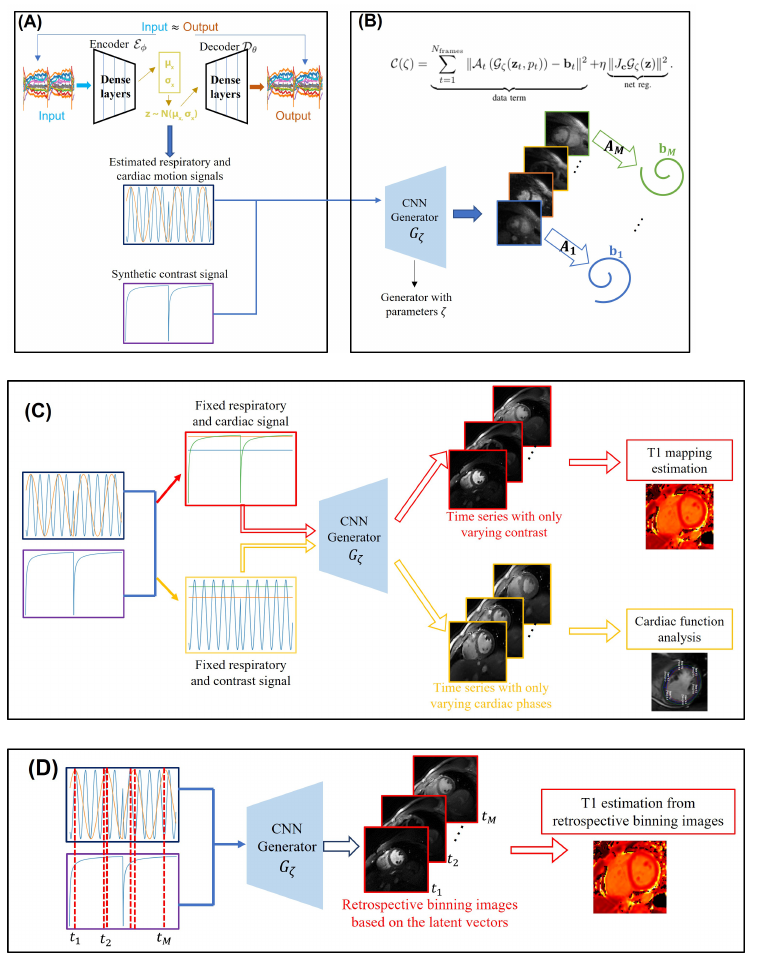
Figure 2. Illustration of the proposed two-step reconstruction scheme. ( A ) shows the estimation of the latent signals from the k-t space navigators using a variational auto-encoder. The center k-space data are used as the input of the encoder, and it tries to learn the motion distribution. ( B ) depicts the reconstruction framework. The estimated latent signals together with the contrast signal, derived from the timing of the inversion pulses, are fed into the generator with parameters θ . The generator then outputs the image frames in the time series with varying contrast, cardiac phase, and respiratory phase. The forward operators are applied for each image frame and compared to the acquired k-space measurements. Post-recovery, the framework can be used in a generative mode as shown in ( C ). For instance, we fix the respiratory and cardiac signals and only vary the contrast signal. These signals are then fed into the learned generator, which then outputs the image frames in the time series that correspond to different inversion times, which are then used for the T 1 estimation. Likewise, the respiratory and contrast signals can be fixed and the cardiac signal can be varied; we can obtain a synthetic breath-hold cine by feeding this combination to the generator. The retrospective binning strategy for T 1 mapping estimation is illustrated in ( D ). Here, we identify the time-instants when the latent vectors are in a specified cardiac and respiratory phase, and we feed the generator the corresponding latent vectors and inversion signal to generate the corresponding images. The T 1 maps are obtained by matching the images with the sub-dictionary of the